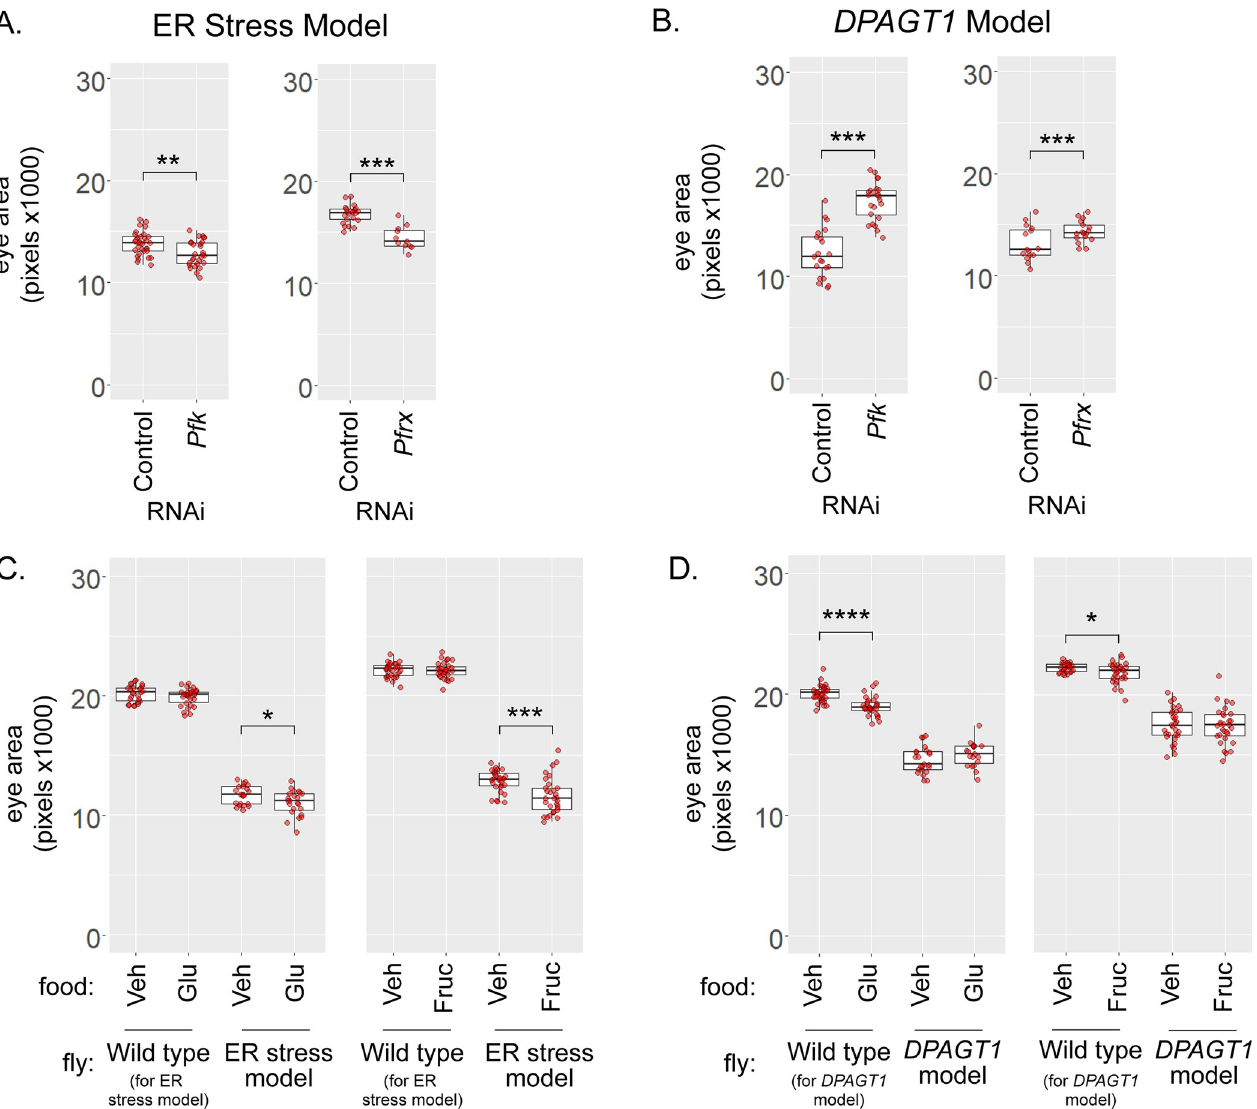
Fig 5. Glucose and fructose metabolism differences between the DPAGT1 and ER stress models. (A-B) In the ER stress model, knockdown of PFKM / Pfk (BDSC 34336) and PFKFB1 / Pfrx (BDSC 57222) causes a worsening of eye size compared to control RNAi (attP2, BDSC 36303; and attP40, BDSC 36304). In contrast, in the DPAGT1 model, knockdown of these genes causes an overall improvement of eye size. (C) 100mM dietary glucose or fructose significantly reduced eye size in the ER stress model. Wild type refers to the genetically-matched background strain. (D) Compared to its background control, feeding of 100mM glucose or fructose was net-positive in the DPAGT1 model. Wild type refers to the genetically-matched background strain. For A-D, 1 replicate is shown of 2 biological replicates (S8 Table), � p < 0.05, �� p < 0.01, ��� p < 0.001 (Student’s t test).